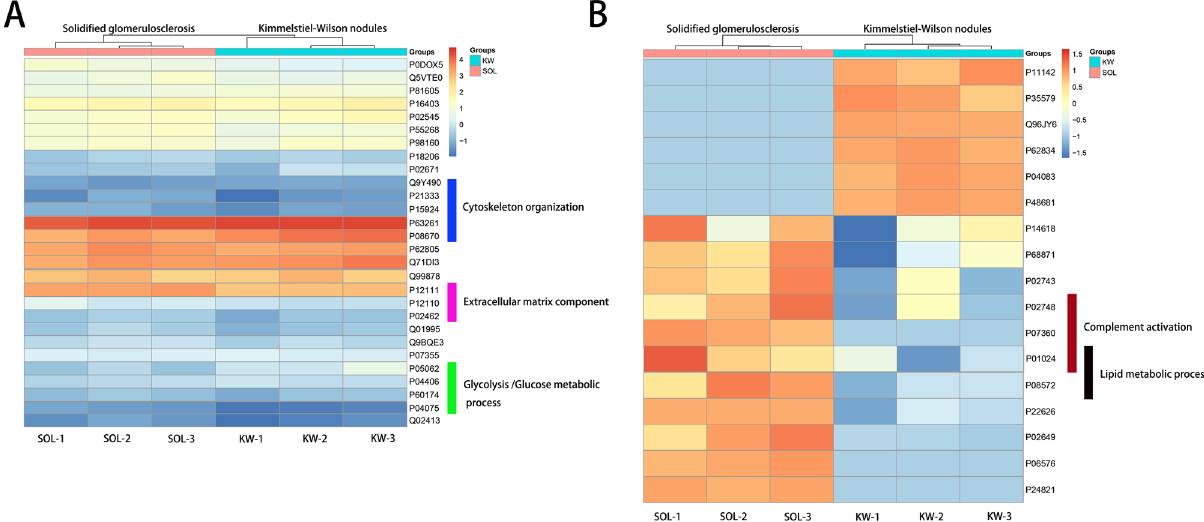
Figure 2. Heatmaps of the proteins identified by laser microdissection and liquid chromatography-electrospray tandem mass spectrometry of solidified glomerulosclerosis and Kimmelstiel–Wilson nodules. The heatmaps are plotted with columns representing the samples and rows representing the pathways. ( A ) Heatmap of proteins that were similarly expressed in solidified glomerulosclerosis lesions and Kimmelstiel–Wilson nodules. The blue bar represents the cytoskeleton organisation pathway, the pink bar represents the extracellular matrix components and the green bar represents glycolysis/glucose metabolic process. ( B ) Heatmap of up- and downregulated proteins in solidified glomerulosclerosis lesions and Kimmelstiel–Wilson nodules. The red bar represents the complement activation pathway and the black bar represents the lipid metabolic pathway.